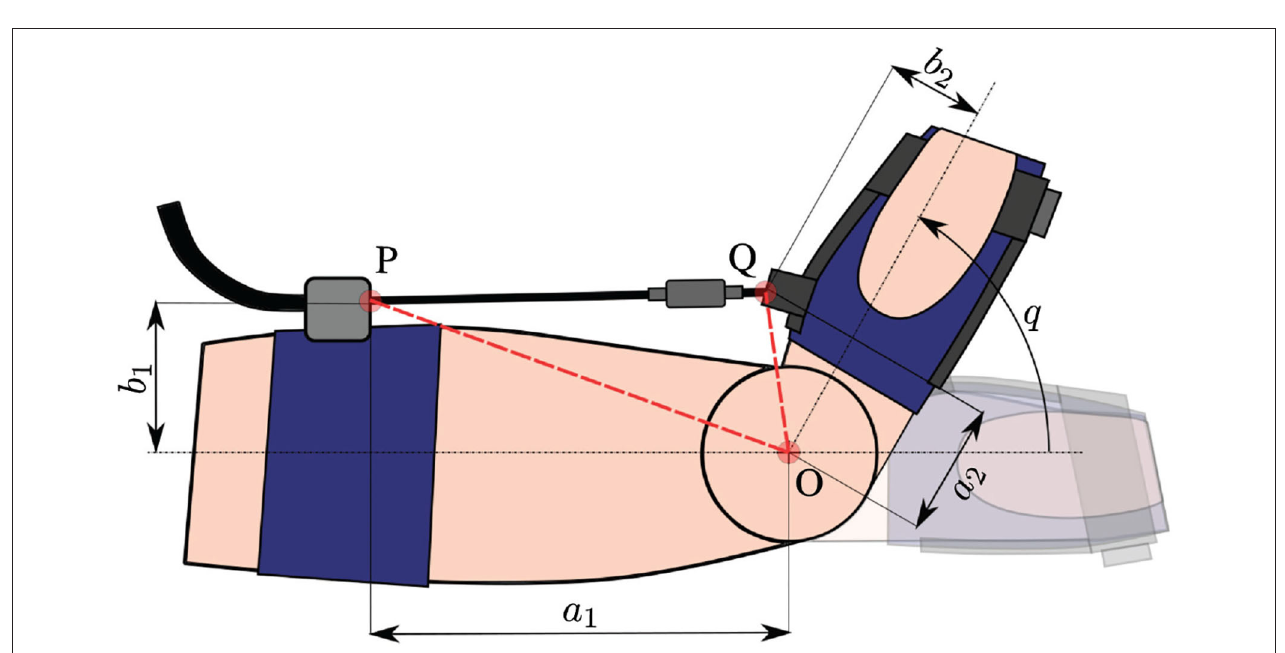
FIGURE 5 | System model: q is the joint angle; O represents the joint rotation axis, while P and Q are the cable anchor points; a 1 , a 2 , b 1 , and b 2 are estimated geometric parameters useful to define anchor points coordinates.